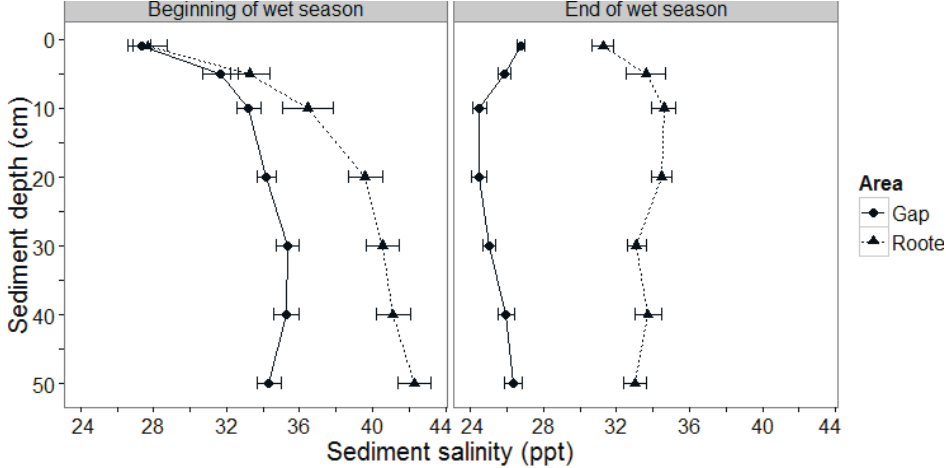
Figure 6. Mean sediment salinity ( n = 21 for each area type) plotted against sediment depth (1, 5, 10, 20, 30, 40 and 50 cm) in gap and rooted areas for the beginning and end of the wet season. Error bars represent the standard error